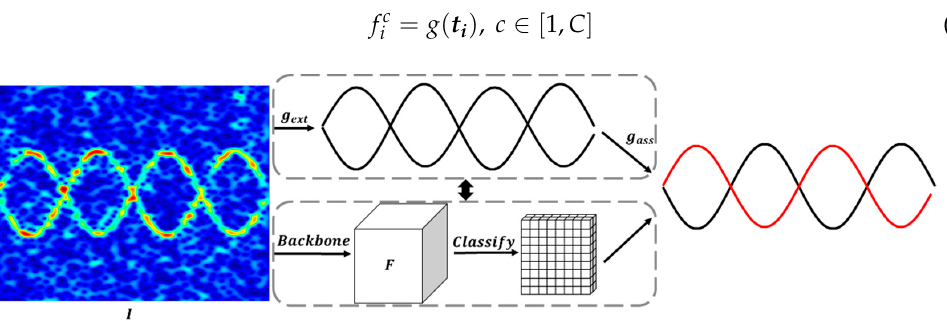
Figure 4. Problem transformation.